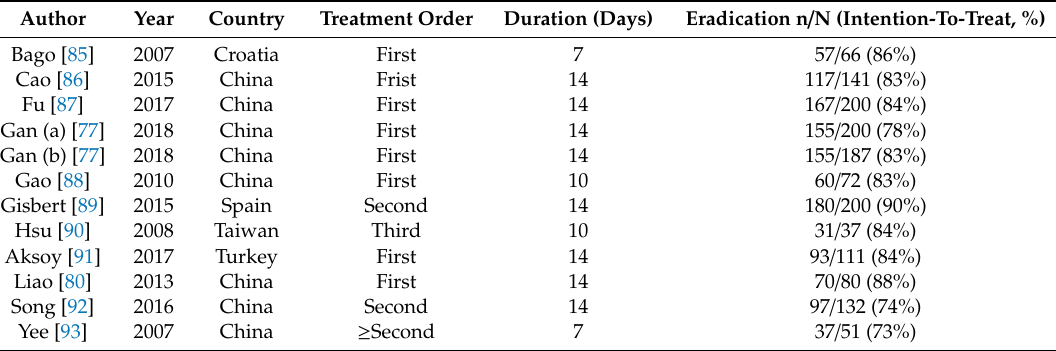
Table 2. Studies evaluating the e ffi cacy of a combination of a proton pump inhibitor, amoxicillin, levofloxacin and bismuth for the eradication of H. pylori